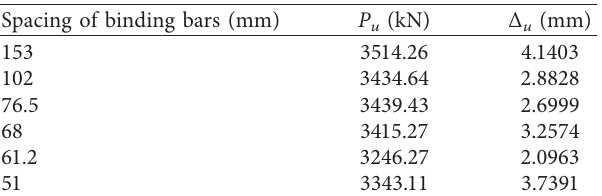
Figure 12: Influence of binding bar spacing on specimen performance. Table 2: Influence of binding bar spacing on ultimate axial bearing capacity and displacement of the specimen.